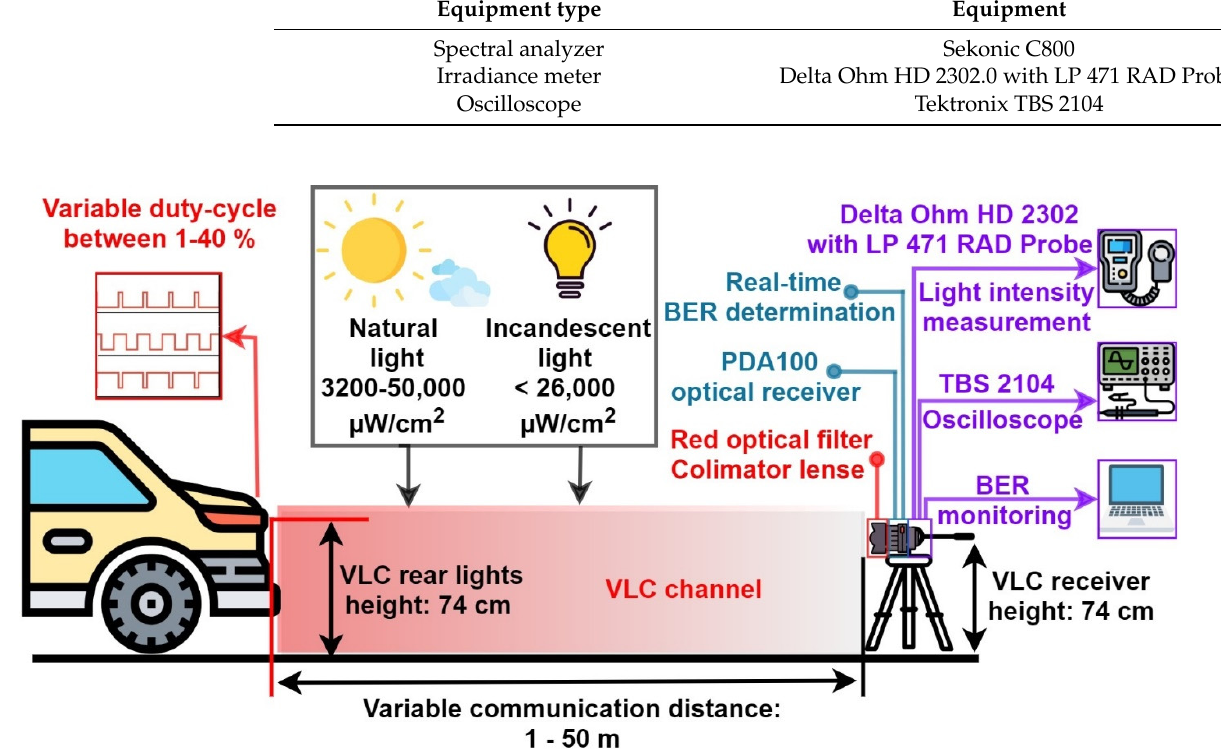
Figure 10. Schematic of the experimental setup.